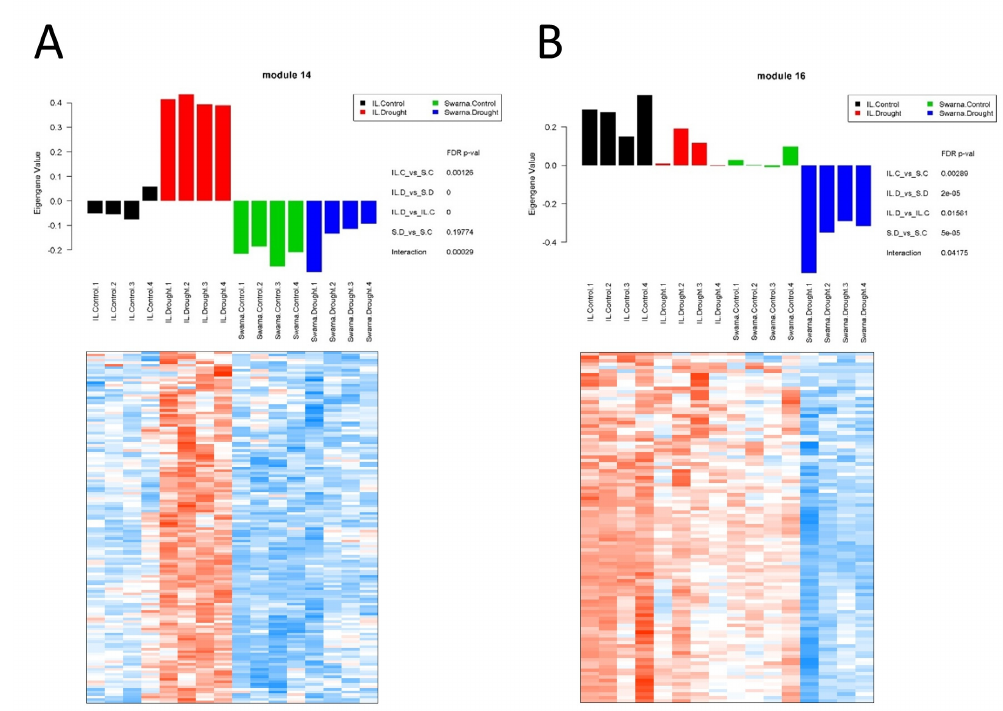
Figure 4. Gene co-expression network analysis in flag-leaf under RDS. Bar plots of the module eigengene as representatives of gene expression profiles across samples in FL-M14 (module 14) ( A ) and FL-M16 (module 16) ( B ). X -axis represents 16 different samples across four different groups, while Y -axis corresponds to the eigengene value. Heatmaps showing gene expression levels of genes in FL-M14 and FL-M16. Columns represent samples, while rows correspond to genes in the module. Red indicates positive and blue negative expression profile. S.C = Swarna control, S.D = Swarna under RDS, IL.C = DTY-IL control, IL.D = DTY-IL under RDS.